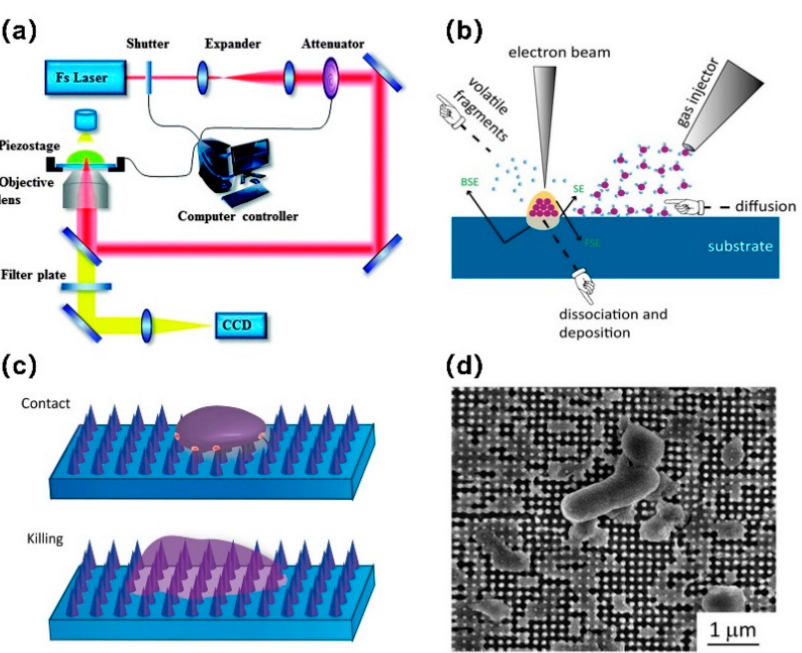
Figure 3. Schematic representation of ( a ) two-photon polymerization (TPP) (Reprinted with permis- sion from ref. [78]. Copyright 2015 Royal Society of Chemistry) and ( b ) electron beam induced depo- sition (EBID); ( c ) schematic diagram showing the bactericidal behavior of a nanopattern structure, including deformation and being sunk on the nanopattern due to the penetration of the nanocolumn into the bacterial cell wall; ( d ) SEM image of damaged Escherichia coli bacteria on the surface of a nanopattern after 18 h of culture, observed from the above [54]. (CCD: Charge-coupled device).